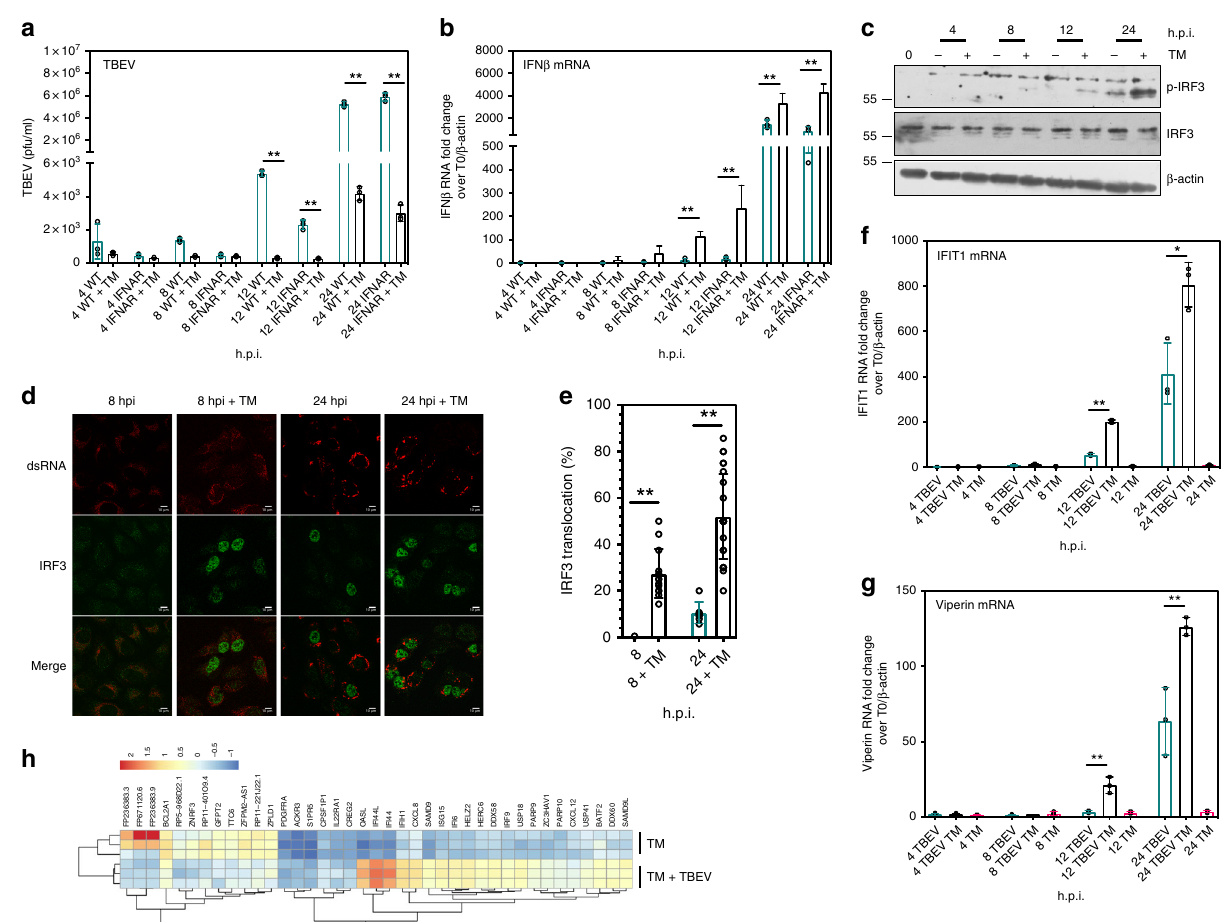
Fig. 3 UPR-induced antiviral signaling following infection is independent of interferon signaling. a Tunicamycin treatment inhibited TBEV yields independently of IFNAR. Primary embryonic MEF Ifnar -/- cells were either infected with TBEV (blue bars) or treated with TM immediately after infection (black bars). At the indicated time points virus yields were measured (PFU/ml). b Tunicamycin treatment of TBEV infected cells led to early IFN β induction. Total RNA from MEF Ifnar -/- infected as above in a was extracted at the indicated time points and used as template for real-time qPCR using primers speci fi c for IFN β . c Tunicamycin treatment led to early IRF3 phosphorylation. U2OS cells were infected with TBEV and treated with TM immediately after infection. At the indicated time points the total protein content was extracted and subjected to immunoblotting with the indicated antibodies. d Tunicamycin treatment led to early IRF3 nuclear translocation. U2OS cells were infected with TBEV and treated with TM immediately after infection. At the indicated time points, cells were fi xed and stained for IRF3 (AlexaFluor 488, green) and dsRNA (AlexaFluor 594, red). Scale bar = 10 μ m. e Quanti fi cation of IRF3 translocation following TBEV infection and Tunicamycin treatment. Cells treated as in d were manually quanti fi ed for IRF3 nuclear translocation at each time point. The graph shows the results from two independent experiments, ∼ 200 cells for each time point. f , g Tunicamycin treatment of TBEV infected cells led to early ISG induction. Total RNA from U2OS cells infected with TBEV moi = 1 was extracted at the indicated time points and used as template for real-time qPCR using primers speci fi c for IFIT1 or Viperin. Values of ISG mRNA from mock-infected cells treated with Tunicamycin were also indicated (magenta bars). h Tunicamycin treatment of TBEV infected cells led an early ISG signature. Transcriptome analysis of cells infected with TBEV compared with infected and treated with TM was performed at 8 h.p.i. in U2OS cells. The cluster of 39 genes